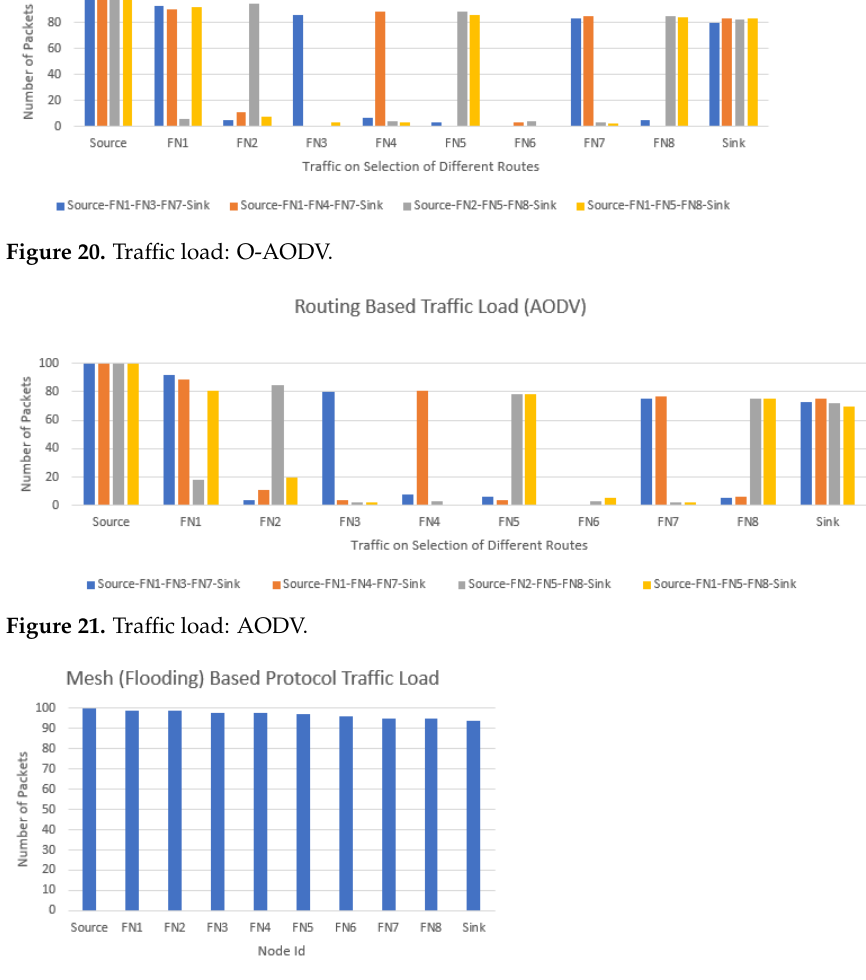
Figure 22. Traffic load: mesh (flooding)-based protocols.